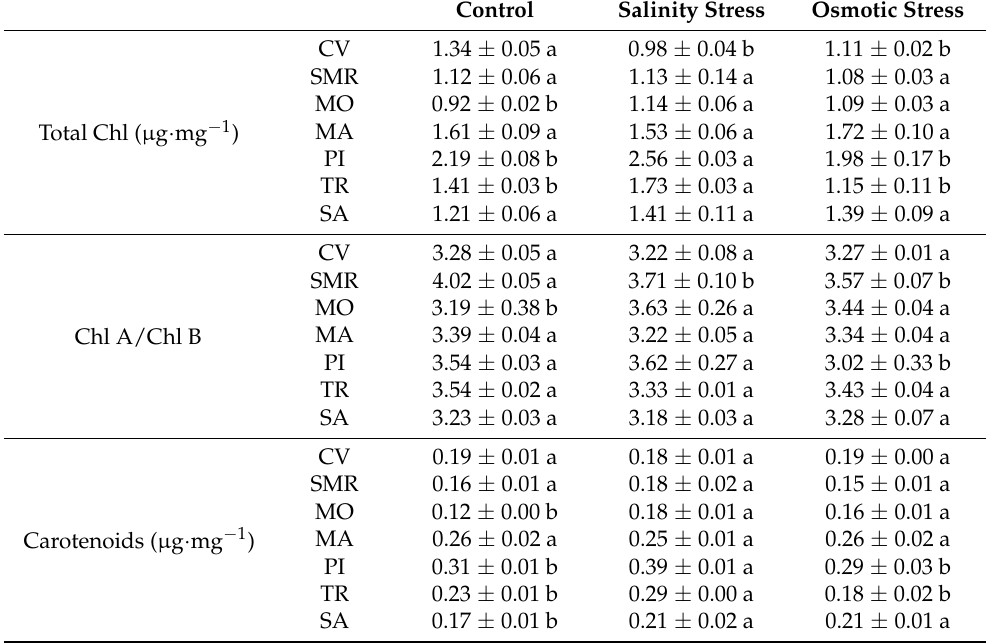
Table 1. Leaf photosynthetic pigment content. Total chlorophyll (Chl) content ( µ g · mg − 1 ), chlorophyll A and B ratio (Chl A/Chl B), and carotenoid content ( µ g · mg − 1 ) of seven common bean populations grown under control, salt-, and osmotic-stress conditions. Data represent the mean ( n = 4) ± standard error. A Student’s t -test was conducted to weigh the effects of different treatments ( p ≤ 0.05). Mean values marked with the same letter are not statistically different. CV: Ciliegino; SMR: San